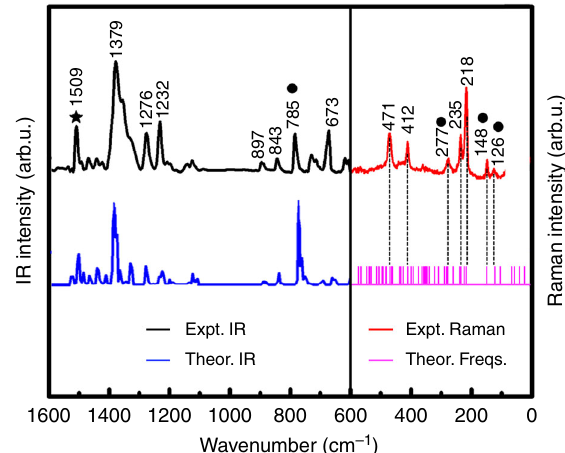
Fig. 4 Observed and theoretically predicted vibrational features of UCU@ I h (7)-C 80 . The left upper curve (black) presents the observed Infrared absorption (IR) spectrum vs. wavenumber from 1600 to 600 cm ‒ 1 , with quantum-chemical density-functional simulation below (in blue). On the right is the observed Raman emission (in red) vs. wavenumber from 600 to 100 cm ‒ 1 , with calculated wavenumbers ( ‘ Theor. Freqs. ’ ) in the 600 – 0 cm ‒ 1 range (below in magenta). Observed local UCU vibrations above 100 cm ‒ 1 are indicated by heavy dots. Observed and calculated spectral C 80 -cage features represent either a single mode, or an overlay of several near-degenerate ones. indicates a contamination by CS